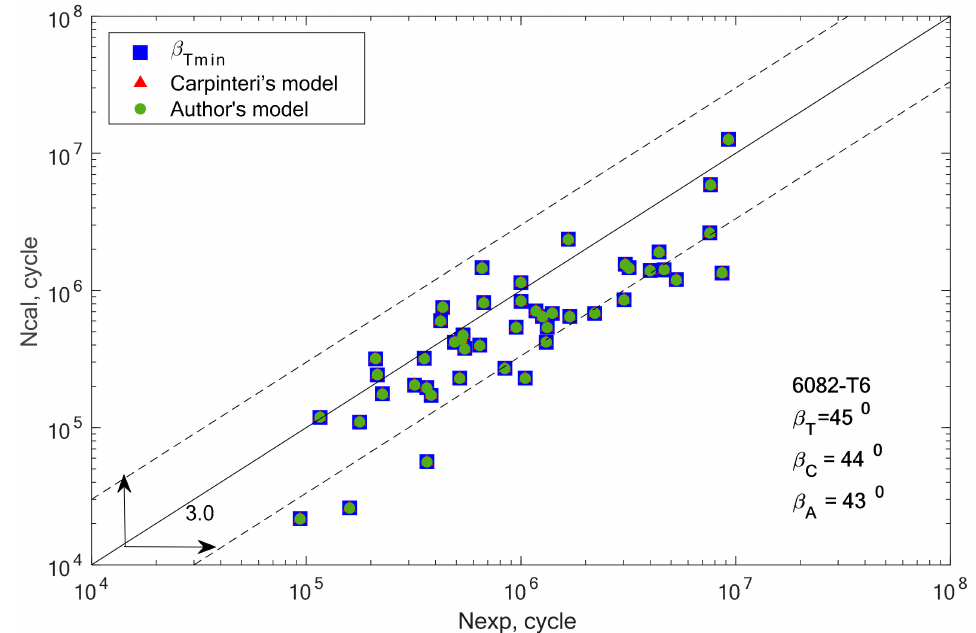
Figure 9. Comparison of the obtained design and experimental fatigue life for aluminium alloy 6082-T6 for the cyclic bending–torsion